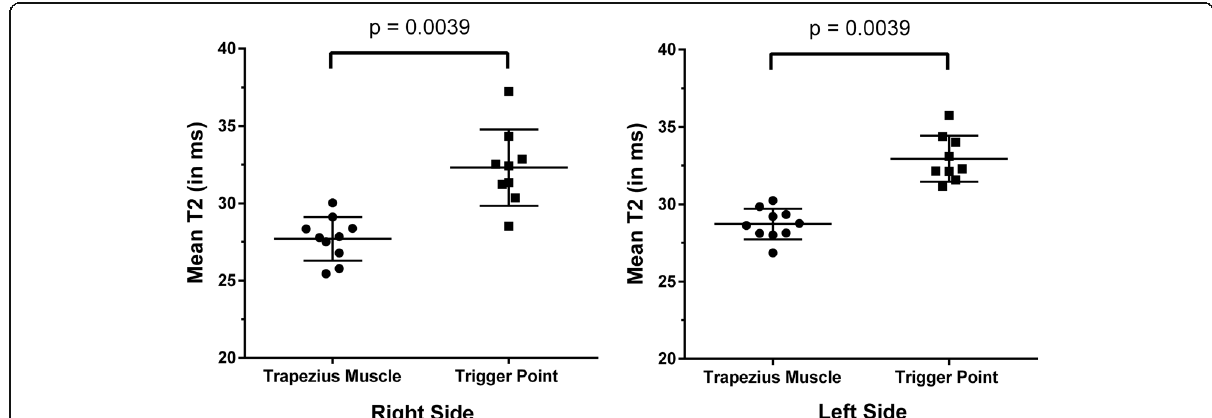
Fig. 2 T2 values of the upper trapezius muscles and myofascial trigger points (mTrPs). The graphs show the T2 values (in ms) of each subject derived from the regions of interest (ROIs) enclosing the trapezius muscles and signal alterations attributed to mTrPs of the right and left side, respectively. Measurements in trapezius muscles were obtained in all subjects bilaterally, whereas measurements of T2 values of signal alterations attributed to mTrPs were achieved in nine subjects per side, respectively (due to missing detectable signal alterations in the remaining subjects). Horizontal lines represent the mean with the standard deviation (SD). A statistically significant difference was observed between measurements for both sides, respectively ( p =